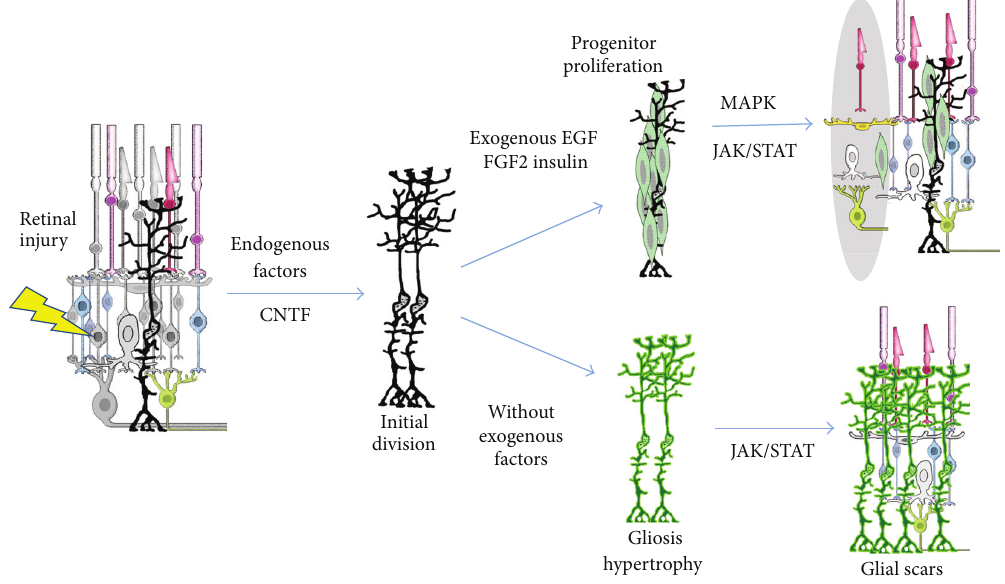
Figure 4: The proposed involvement of CNTF, JAK/STAT, and MAPK signaling in gliosis and neural regeneration by M¨uller glia in mammalian retina. Retinal injury (lightning bolt) kills retinal cells (gray cells) and stimulates release of growth factors, including CNTF, resulting in limited cell division of M¨uller glia (MG). In the absence of exogenous growth factors, increased JAK/STAT signaling (lower arrows) in activated MG promotes gliosis (bright green), resulting in glial scars, but neurons are not regenerated. Activation of MAPK and JAK/STAT signaling by exogenous factors, including EGF, FGF2, and insulin (upper arrows), produces proliferative progenitors (light green), which can regenerate some retinal neurons (in gray shaded oval), such as amacrine cells [62] and photoreceptors [63]. Some undifferentiated progenitor cells (light green) persist following resolution of the regenerative response. Even with exogenous factor stimulation, mammalian retinas fail to restore all lost